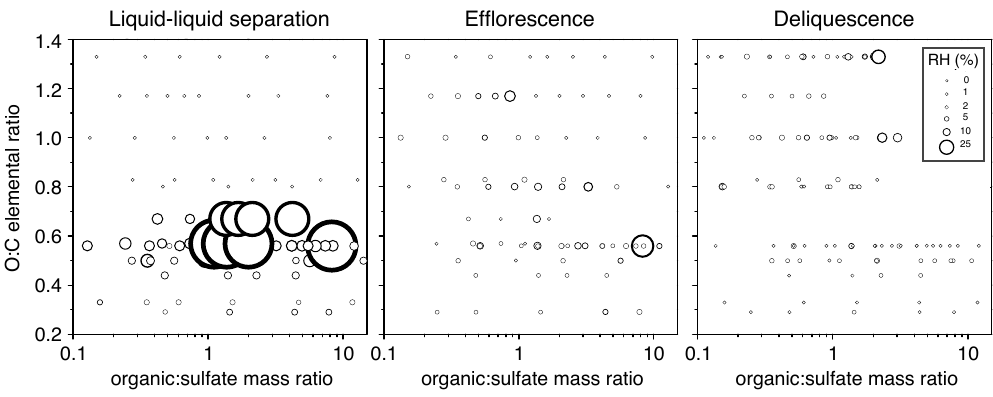
Fig. 5. The residuals (defined as the difference between parameterisations and measurements) for SRH, ERH, and DRH. The diameter of the circles correspond to the difference between the parameterisations and the measurements in % RH.